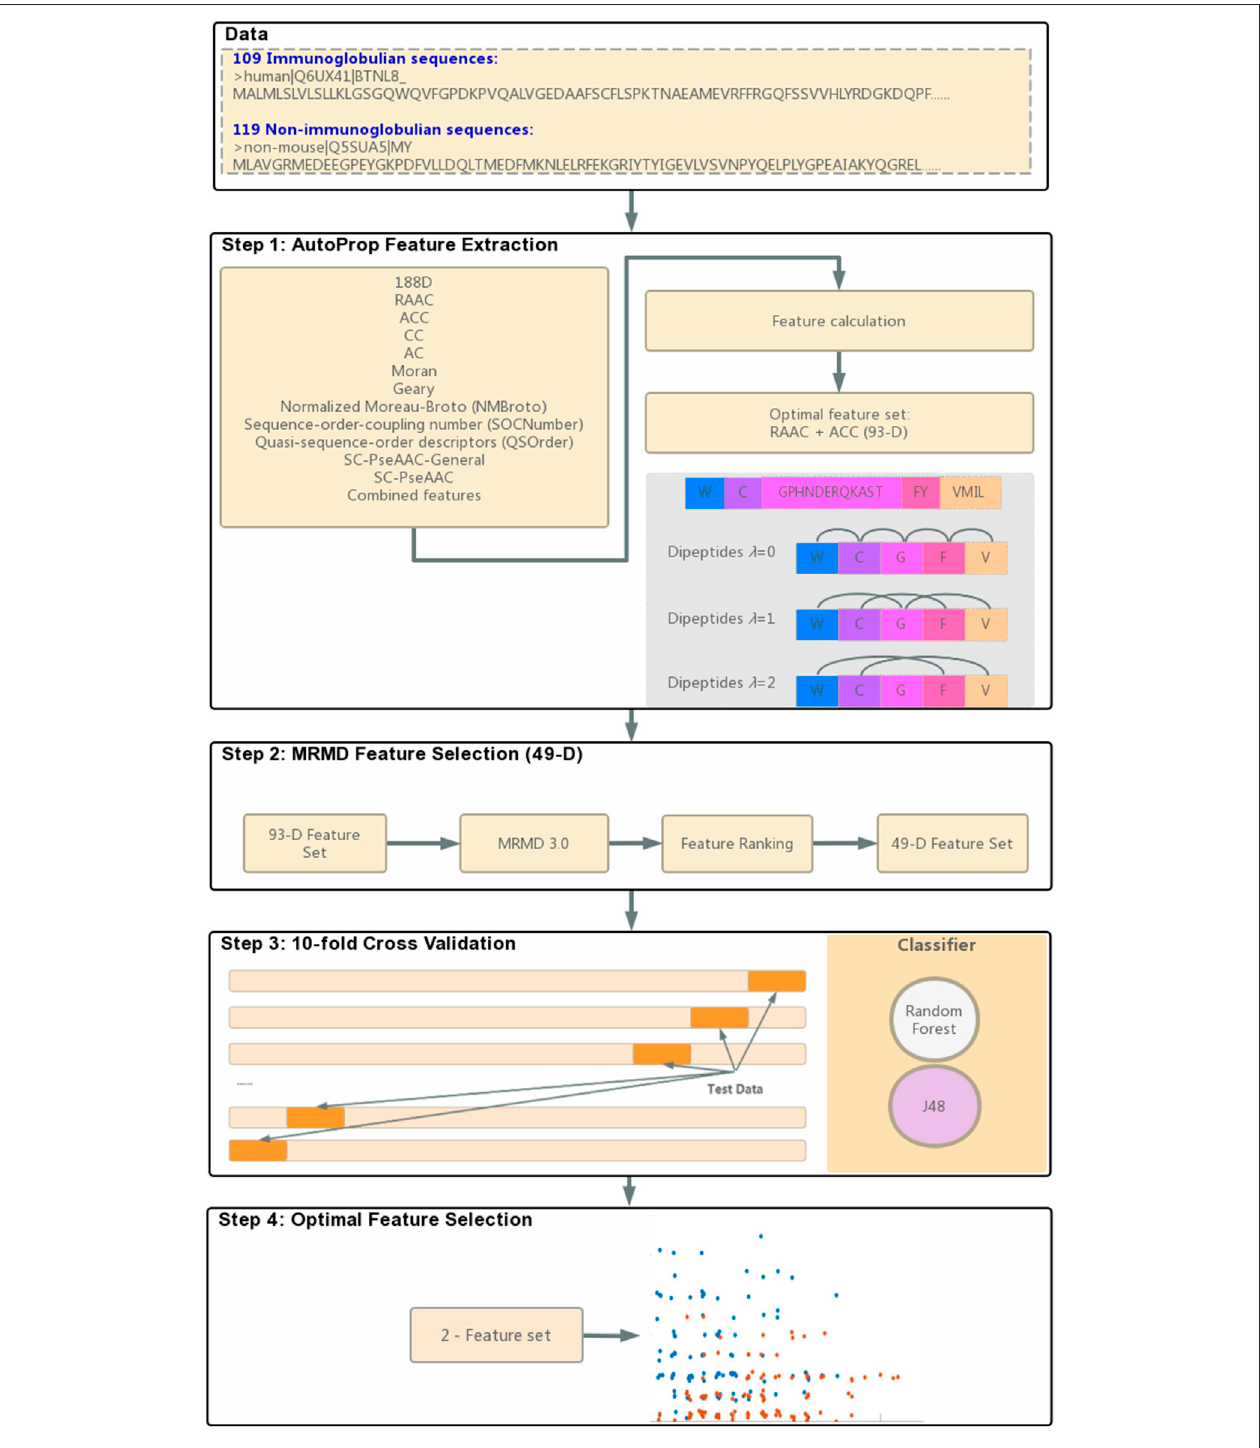
FIGURE 1 | Flowchart of identifying immunoglobulins.